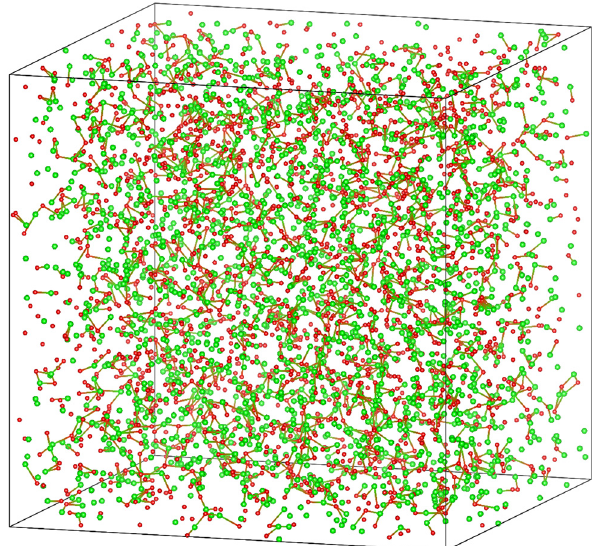
Figure 5: Picture of three dimensional configuration of liquid Pb 0.5 Te 0.5 by using RMC simulation. Red and green indicate tellurium and lead, respectively. The covalent bonds indicated by a colored line between Te and Pb occur in the cases of ≦ r 0.262 nm .